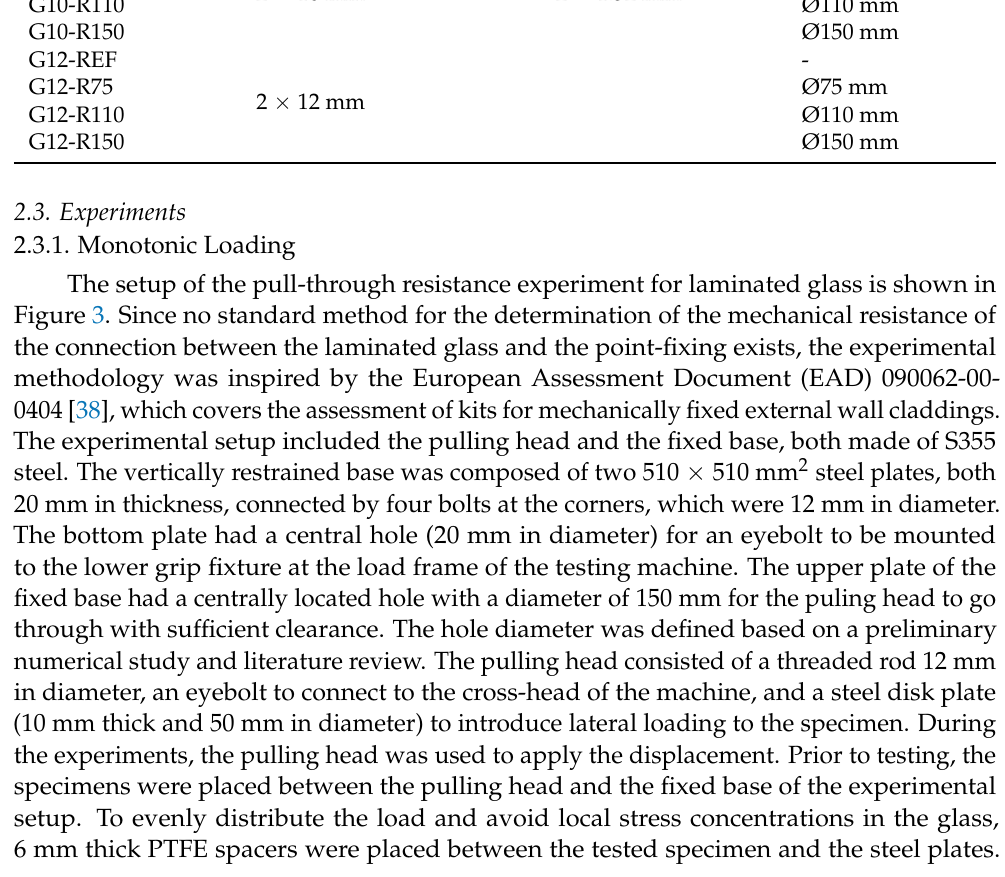
Figure 2. Produced samples: ( a ) plan view; ( b ) exploded view. Dimensions in mm. Unreinforced samples (REF) consisted only of glass panes and the interlayer, while in the case of reinforced samples (R), a woven stainless steel mesh of different diameters was placed between two layers of the interlayer before the lamination process. The steel mesh consisted of wires (0.35 mm in diameter) at a spacing of 1 × 1 mm 2 . For further vali ‐ dation of the numerical models, strain gauges were mounted at 55 mm from the hole’s edge on selected samples. Three different pane thicknesses and three diameters of rein ‐ forcement were considered in this study. This led to a total of 12 test series and 48 speci ‐ mens (see Table 1). Table 1. Overview of the produced specimens. In the test series, “G” stands for glass build ‐ up, while “R” indicates the diameter of the steel mesh in the reinforced samples.